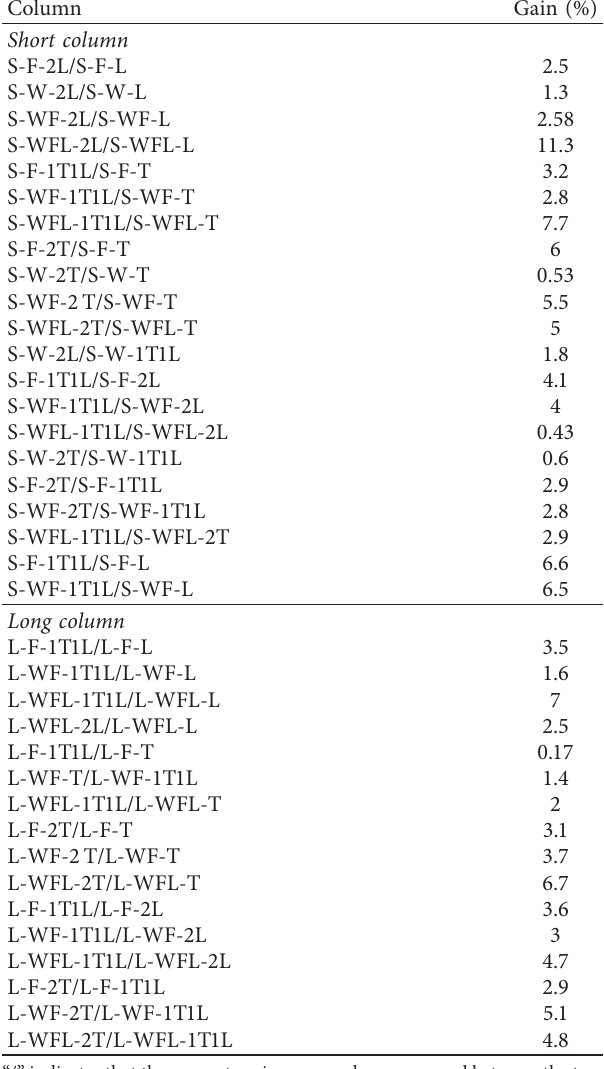
Table 7: Component growth percentage.